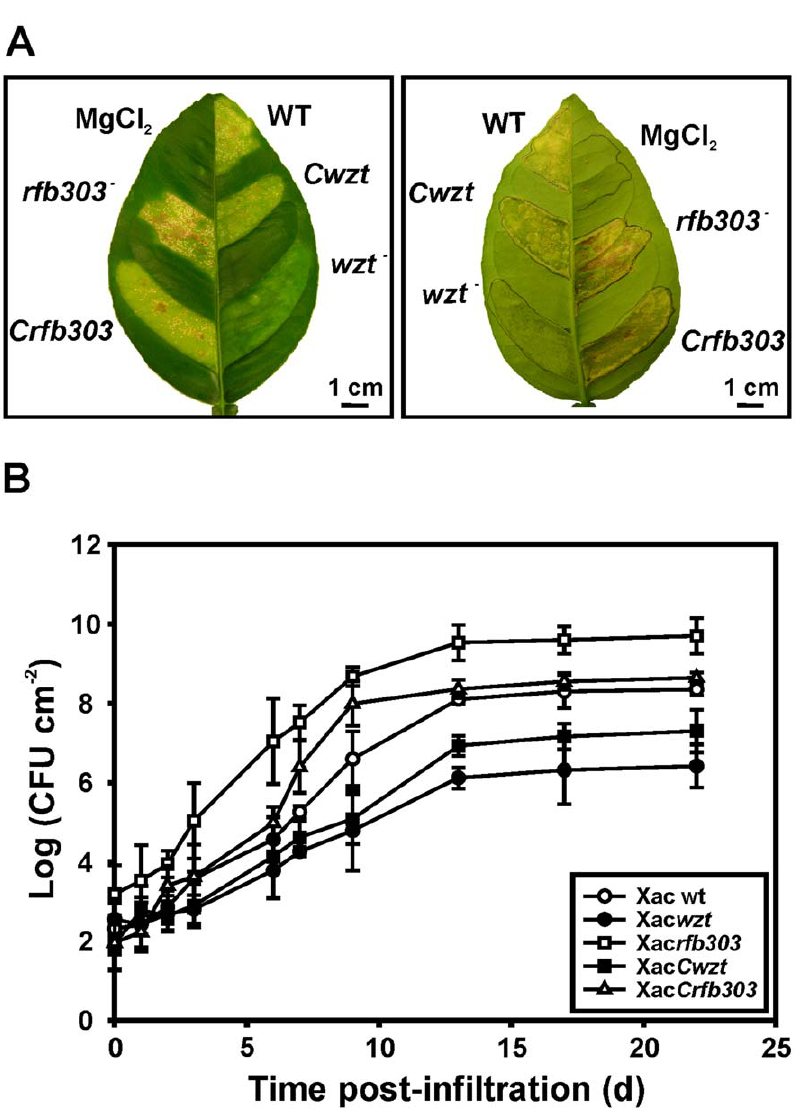
Figure 7. Effect of wzt and rfb303 disruption on pathogenicity in host plants. (A) Disease symptoms on orange leaves inoculated with Xac wild-type, the LPS mutants Xac wzt and Xac rfb303 and the complemented strains Xac Cwzt and Xac Crfb303 at 10 7 CFU ml 2 1 in 10 mM MgCl 2 . A representative leaf 13 days after inoculation is shown. Left panel, adaxial side; right panel, abaxial side. Scale bars, 1 cm. (B) Bacterial growth of Xac cells in orange leaves during 22 days. Values represent means 6 standard deviations of three independent samples.